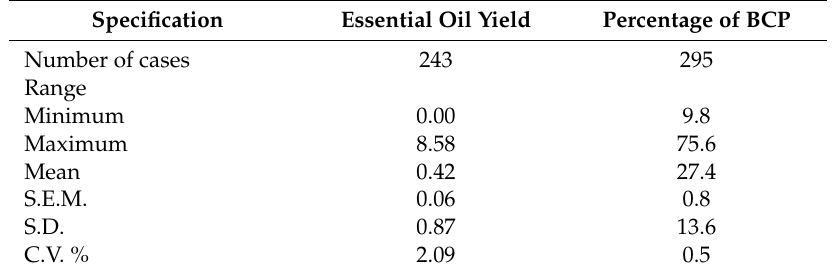
Table 2. General statistics on BCP and yield percentages of plant species listed in Table